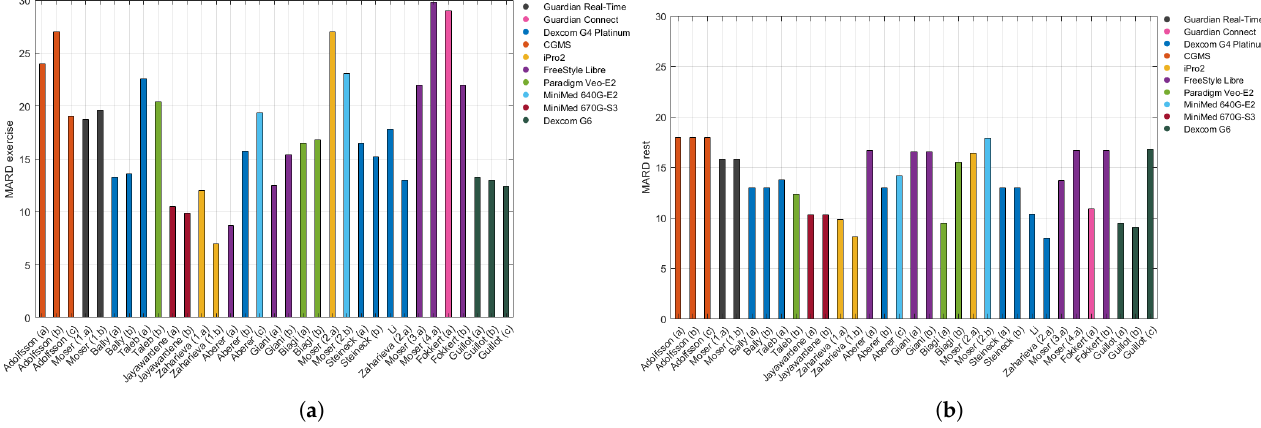
Figure 2. Panel ( a ) shows the MARD for the exercise periods in chronological order of the publication, coloured according to the CGM system used, and Panel ( b ) depicts the MARD of the rest periods, presented in the same